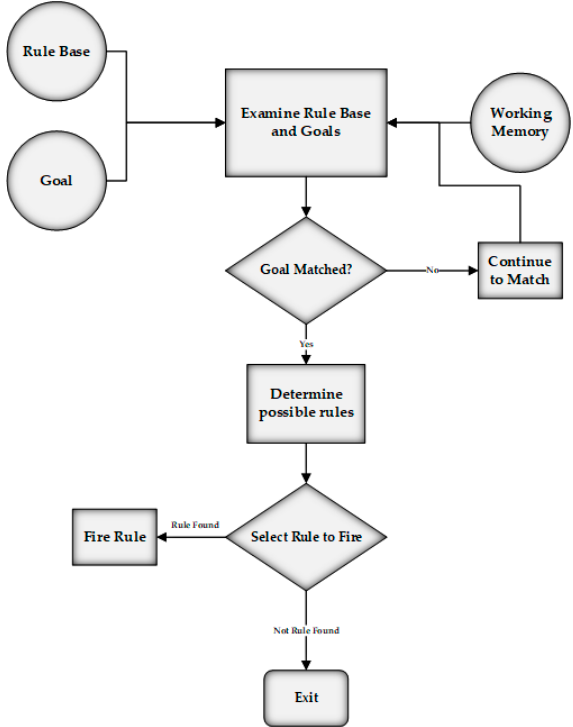
Figure 6. Workflow of firing a rule in inference engine.